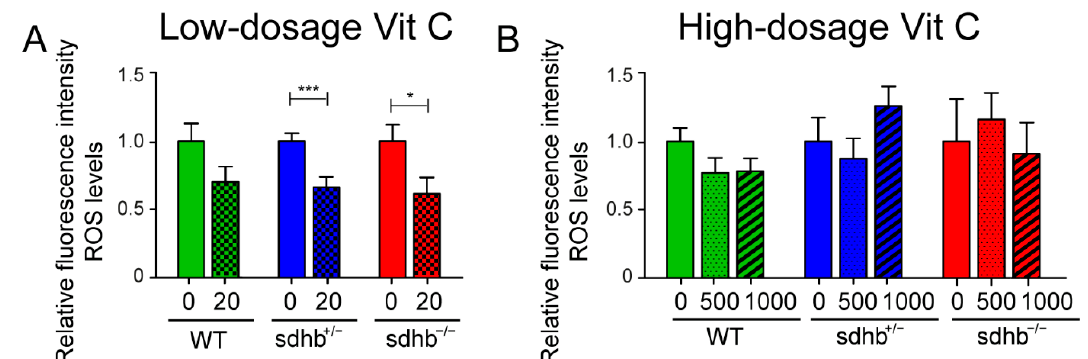
Figure 4. Reactive oxygen species (ROS) measurements after a low- and high-dosage Vitamin C treatment. Relative average fluorescence levels are shown normalised to control levels without Vitamin C supplementation. ( A ) Larvae were supplemented with 20 mg ⋅ L − 1 Vitamin C homozygous sdhb ( n = 22), heterozygous sibling ( n = 33), and wild-type sibling ( n = 21) compared to the control group (indicated with 0 mg ⋅ L − 1 ) consisting of homozygous sdhb larvae ( n = 24), heterozygous sibling ( n = 38), and wild-type sibling ( n = 18) from two different replicates measured at 6 dpf. Low-dosage levels of Vitamin C significantly decreased ROS levels in heterozygous and homozygous sdhb larvae compared to the untreated control group. ( B ) Larvae were supplemented with 500 mg ⋅ L − 1 Vitamin C homozygous sdhb ( n = 12), heterozygous sibling ( n = 24), and wild-type sibling ( n = 18); 1000 mg ⋅ L − 1 Vitamin C homozygous sdhb ( n = 8), heterozygous sibling ( n = 22), and wild-type sibling ( n = 22) compared to the control group (indicated with 0 mg ⋅ L − 1 ) consisting of homozygous sdhb larvae ( n = 10), heterozygous sibling ( n = 14), and wild-type sibling ( n = 16) from three different replicates measured at 6 dpf. High-dosage levels of Vitamin C did not alter ROS levels in all three genotypes compared to the untreated control group. Two-tailed unpaired Student’s t -test, * p < 0.05 and *** p < 0.001.